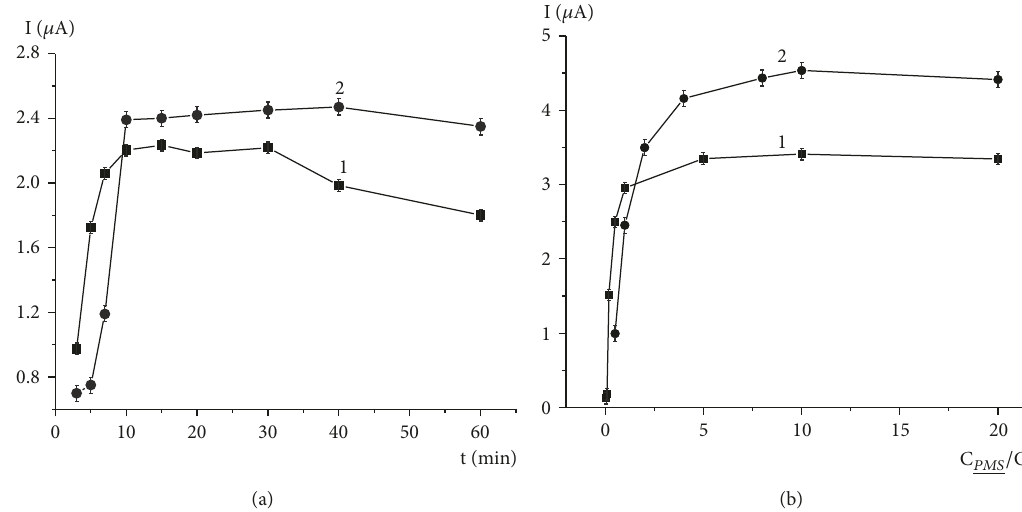
mol ⋅ L −1 ; C buffer ∼ 0.2 mol ⋅ L −1 , and a H=4.0.